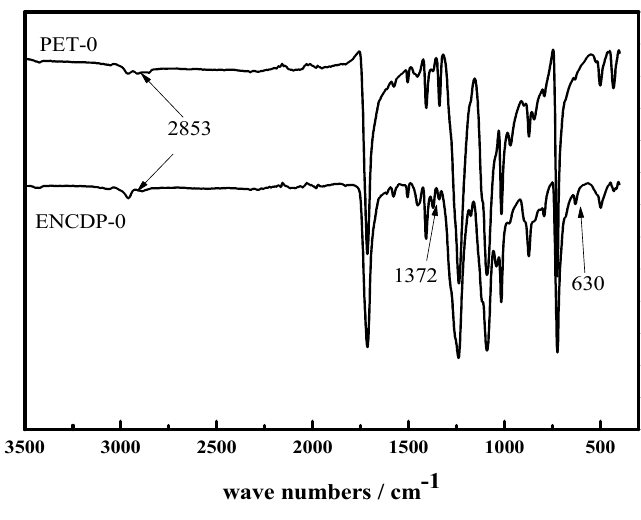
Figure 1. FTIR spectra of PET-0 and ENCDP-0. Table 3. The wave numbers and vibrational conformation of chemical groups.